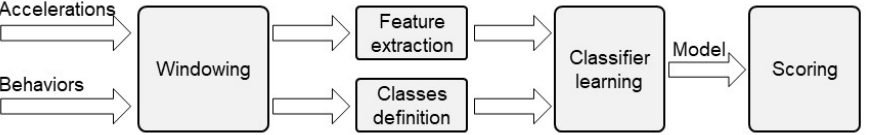
Figure 5. Methodological flow for the development and validation of the model for behavior iden- tification.